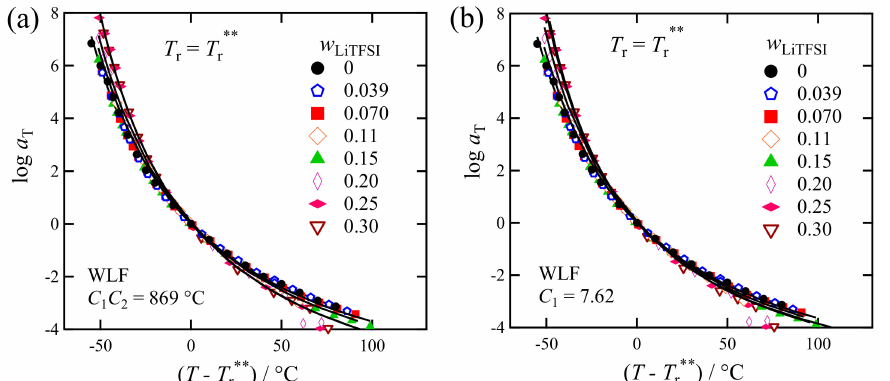
Figure A1. T - T r** dependence of the shift factors with the reference temperature T r** shown in Table 1. The solid curves in figure ( a ) represent the WLF functions given by Equation A1 with the parameter sets shown in Table A1. The solid curves in figure ( b ) also represent the WLF functions with different parameter sets, i.e., C 1 was fixed to be 7.62, and C 2 was varied (see Table